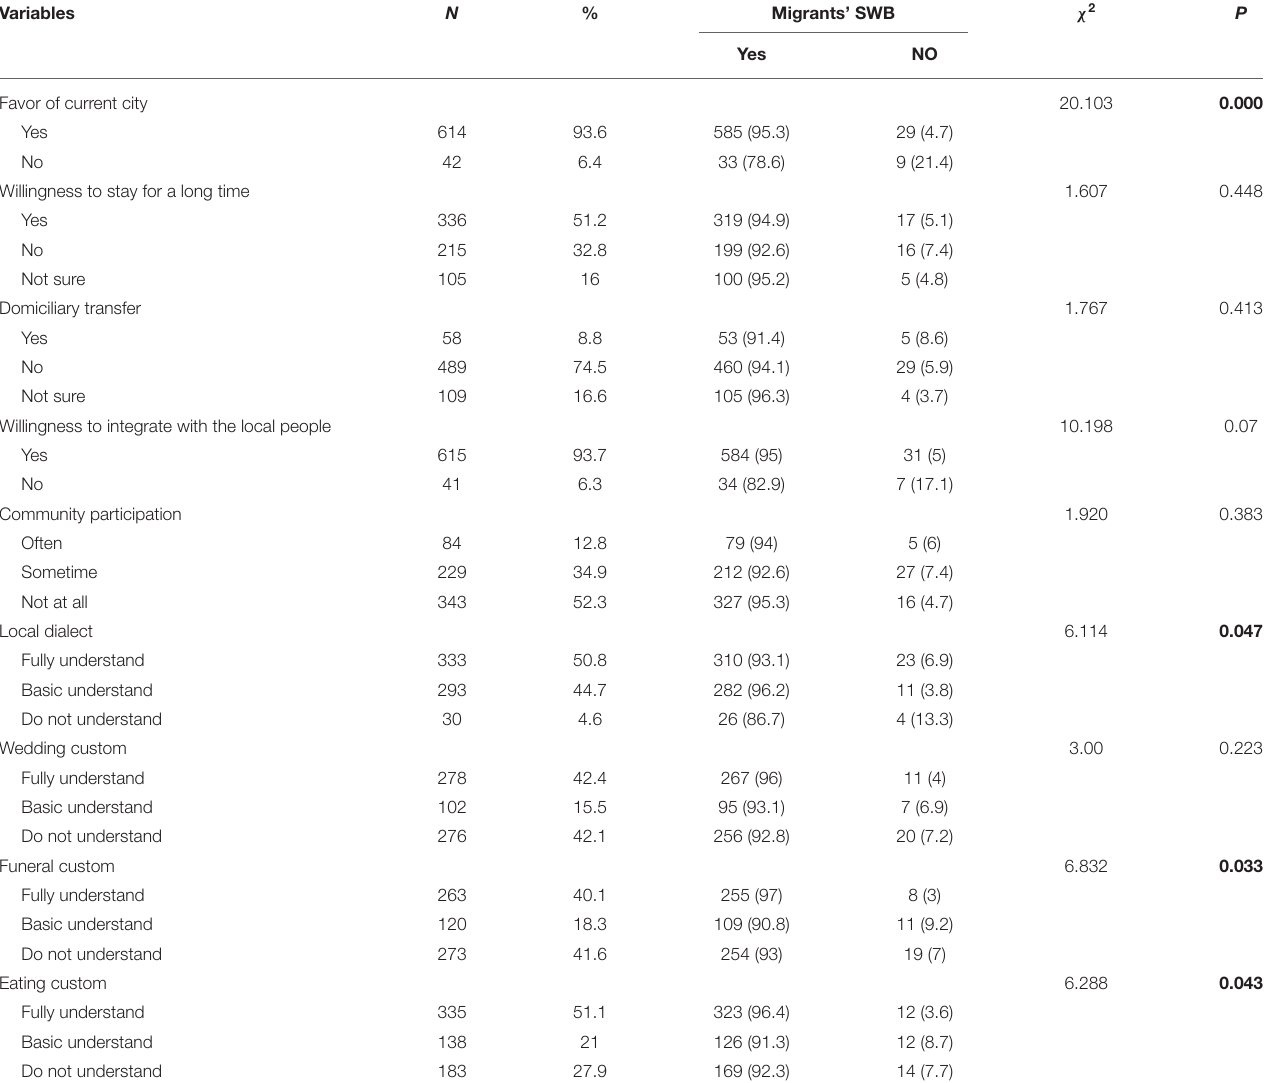
TABLE 3 | Social integration of migrant elderly following